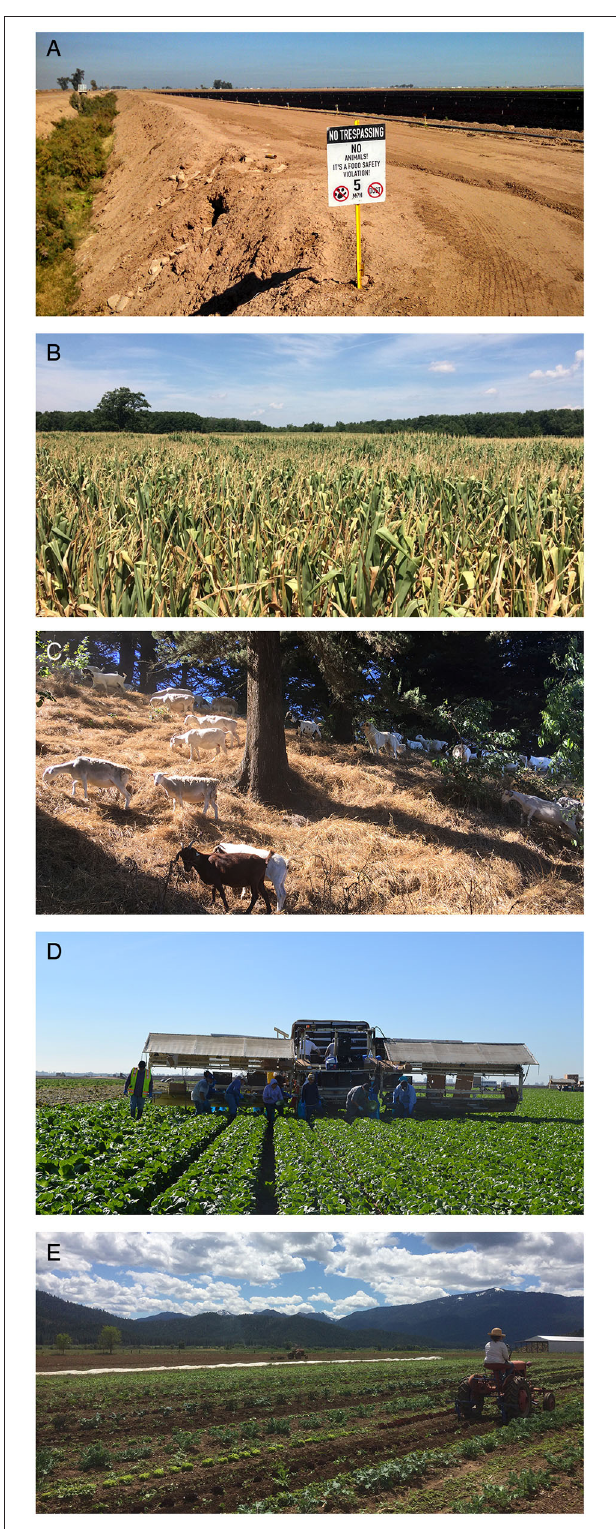
FIGURE 2 | Five cases of challenges in which farming systems must adapt to the triple threat: (A) Pathogens: A no-trespassing sign at the edge of a lettuce field in California, warning, “No animals! It’s a food safety violation!”